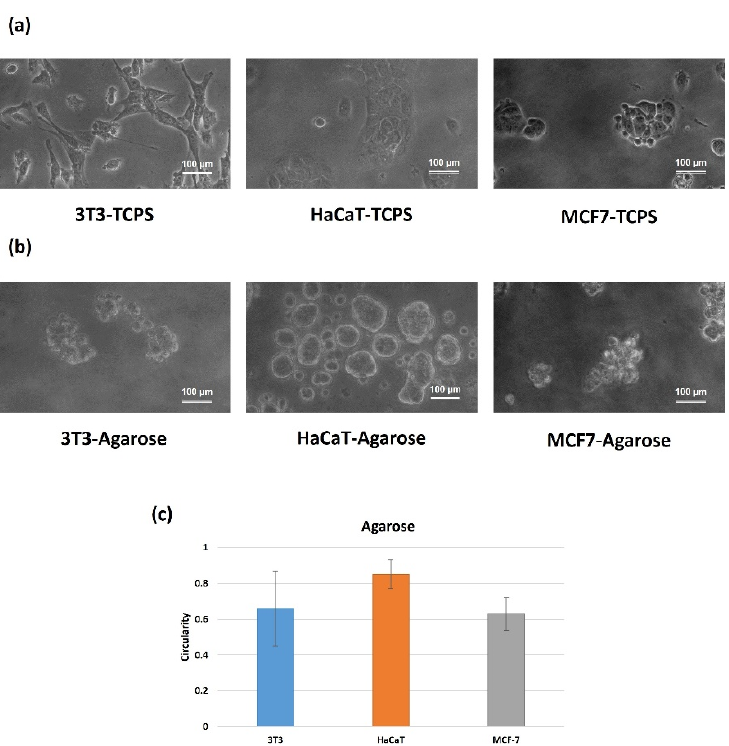
Figure 2. Representative phase-contrast images of cells in 2D culture ( a ), spheroid-like structures ( b ) prepared in 0.4% ( w / v ) agarose, and ( c ) measure of the circularity of the agarose-induced structures. Results are expressed as the average of more than 10 single spheroids ± standard deviation. Scale bars represent 100 µm.